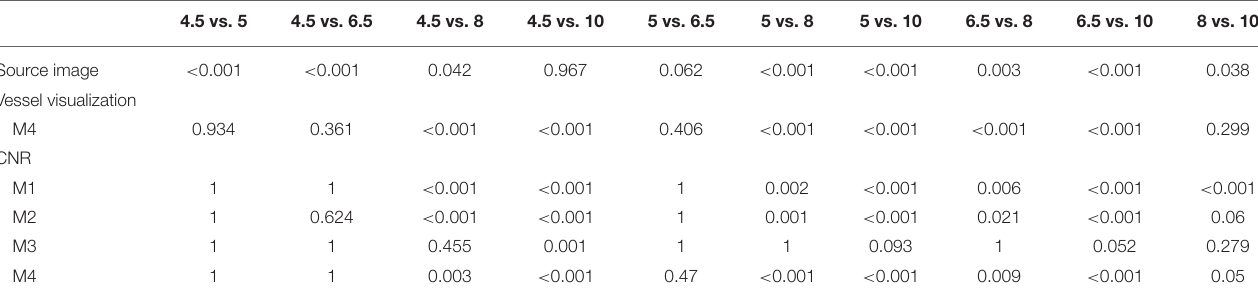
TABLE 2 | Exact p -value of post-hoc analysis in significantly different Friedman test and repeated measures one-way